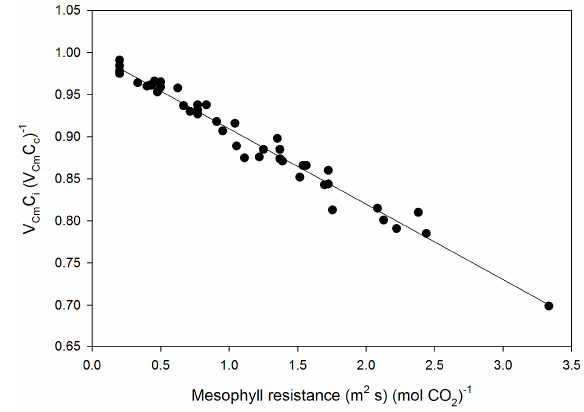
Figure 4. Relationships between the ratio of g m to g s and WUE ( a ); and between g m and C i ( b ) for all measurements made on fifteen cultivars of soybean. The correlation between the g m to g s ratio and WUE had an r value of +0.53, and that between g m and C i was +0.116, which was not significant at p = 0.05.